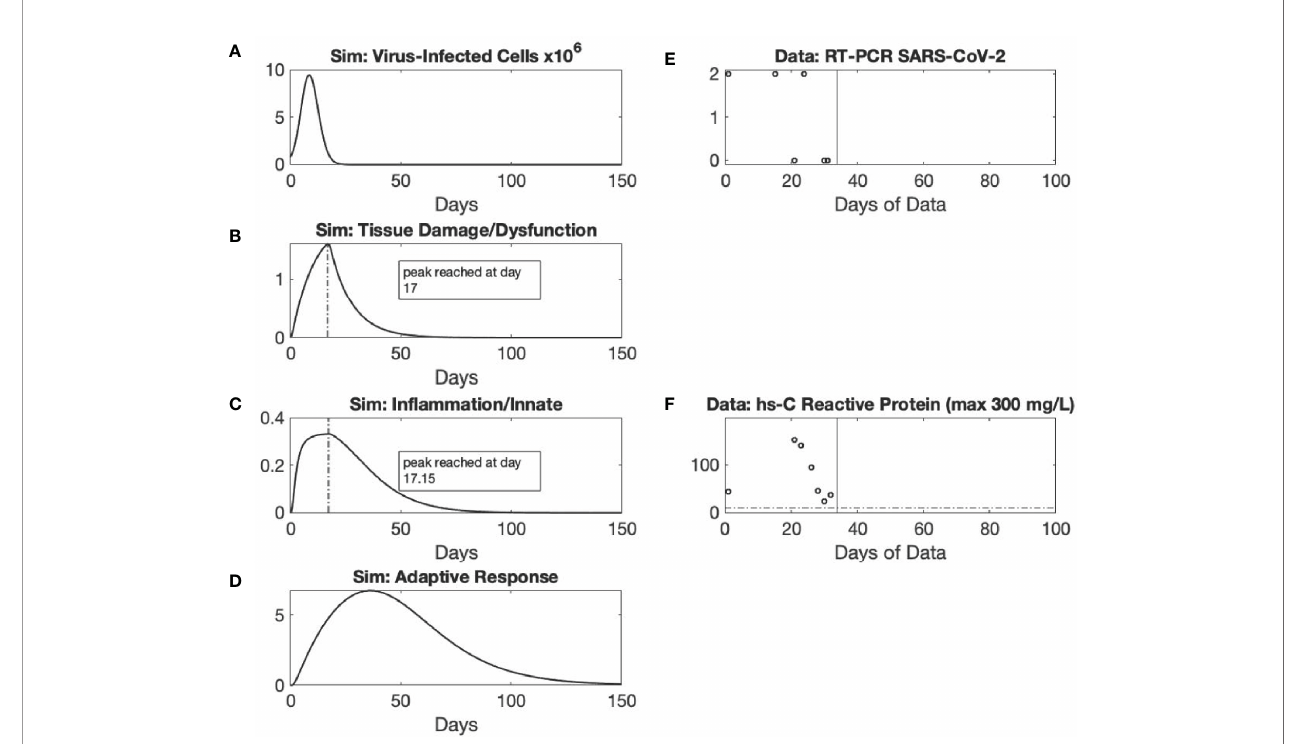
FIGURE 3 | Recovery archetype, Mild response scenario: simulation vs . patient data. Using the baseline set of model parameter values, simulated dynamics are shown of variables C V (Panel A ) (Initialized with a C V =8x10 5 virus-infected cells), D (Panel B ), I (Panel C ), and A (Panel D ). The following six parameters with their baseline values given are those used in the simulation of the Mild scenario and are the subset of parameters whose values may differ between the Mild scenario and other scenario simulations as speci fi ed within Table S1 : k di =0.3; x di =1.0, x iainv =0.1; k ai =3.0; k ii =0.1; k id =0.35. Panels (E, F) show data from a patient in their 60s with hypertension, diabetes, and chronic kidney disease who tested positive for SARS-CoV-2 while asymptomatic, as a result of screening for a planned procedure. The patient had the opportunity to be tested several more times over the ensuing weeks while hospitalized for non-related medical problems. For the entirety of their hospitalization (black vertical lines denote discharge), the patient was not overtly symptomatic for